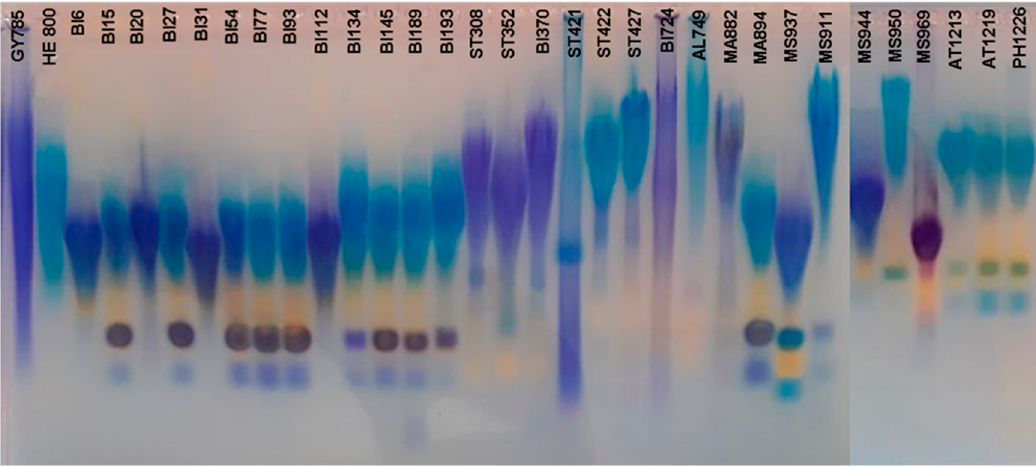
Figure 1. Electrophoresis on agarose gel with Stains All staining of EPS produced by 31 deep-sea hydrothermal vent bacteria.